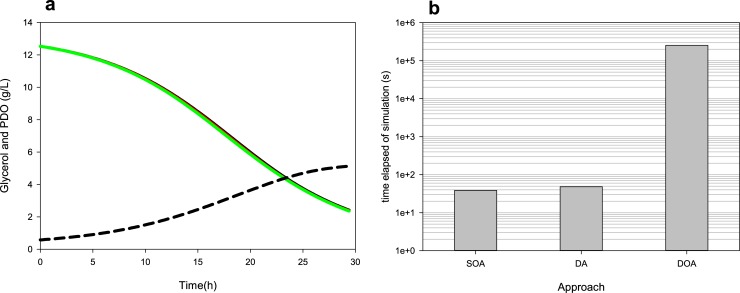
Comparison DFBA predictions using the DOA, SOA, and DA approaches.(a) Glycerol consumption (continuous lines) and PDO production (dashed lines) profiles using DOA (green lines), SOA (black lines), and DA (red lines) approaches. (b) Elapsed time during DFBA solution using different approaches.